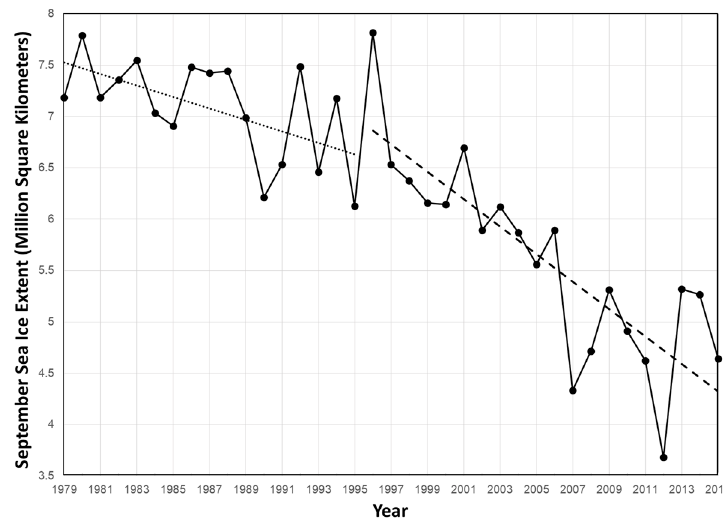
Figure 1. September Arctic sea ice extent (SIE) change from 1979 to 2015.